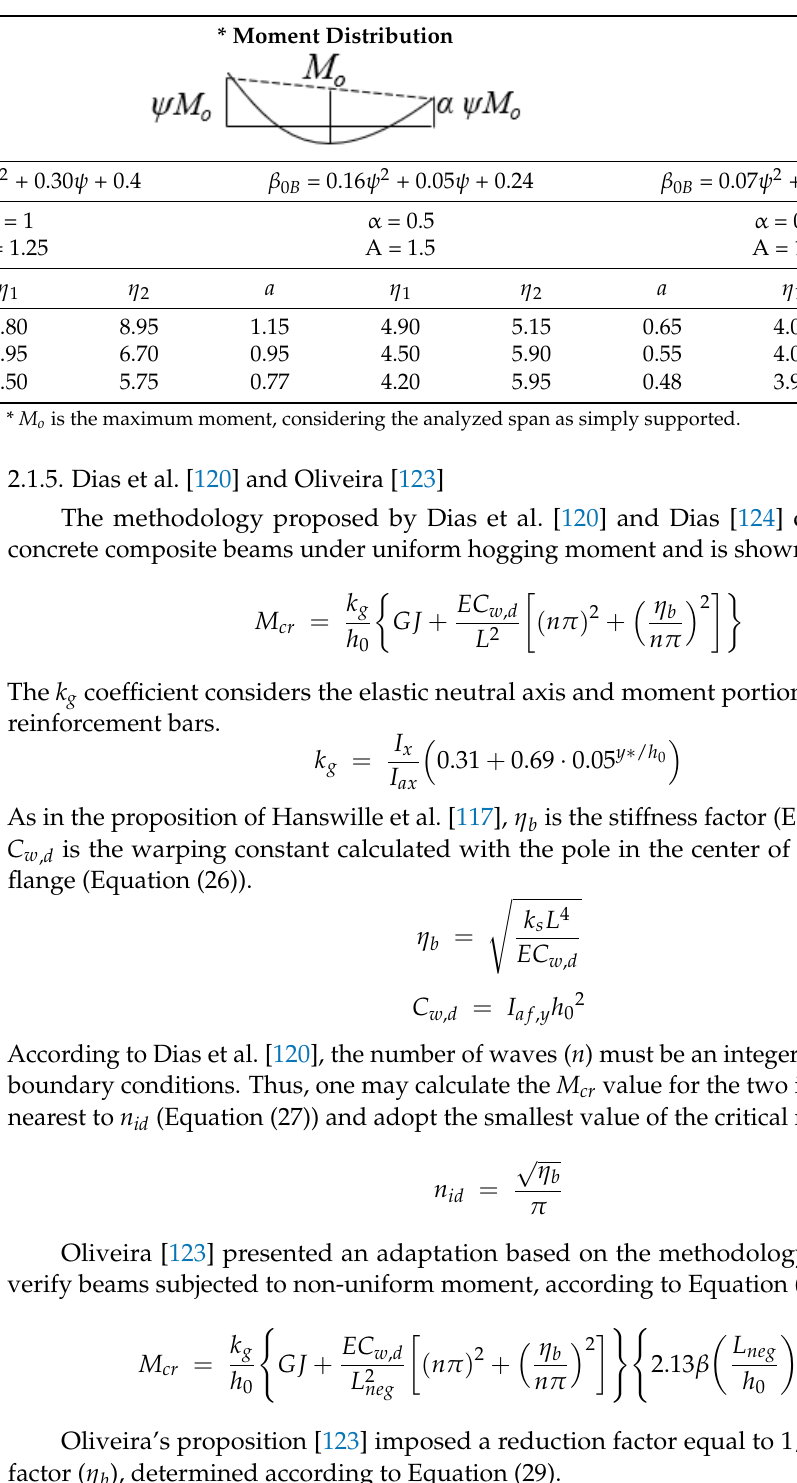
Table 7. Approximate determination of the elastic critical moment for members with uniformly distributed load and end moments. Adapted from Hanswille et al. [117].